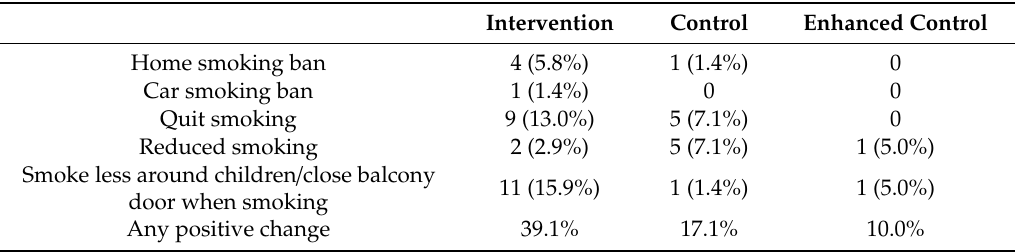
Table 3. Change in behavioural outcomes by study end N (% of families in which the change was reported). Intervention Control Enhanced Control Home smoking ban 4 (5.8%) 1 (1.4%)